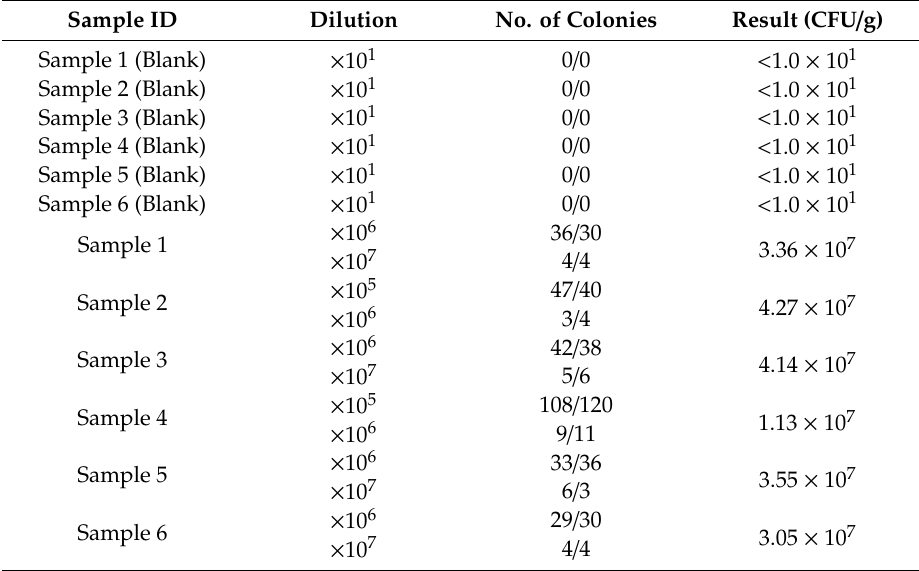
Table 4. Results obtained with the plate count method in cosmetic samples spiked with Escherichia coli . Enumeration is expressed both as number of colonies and CFU / g for each